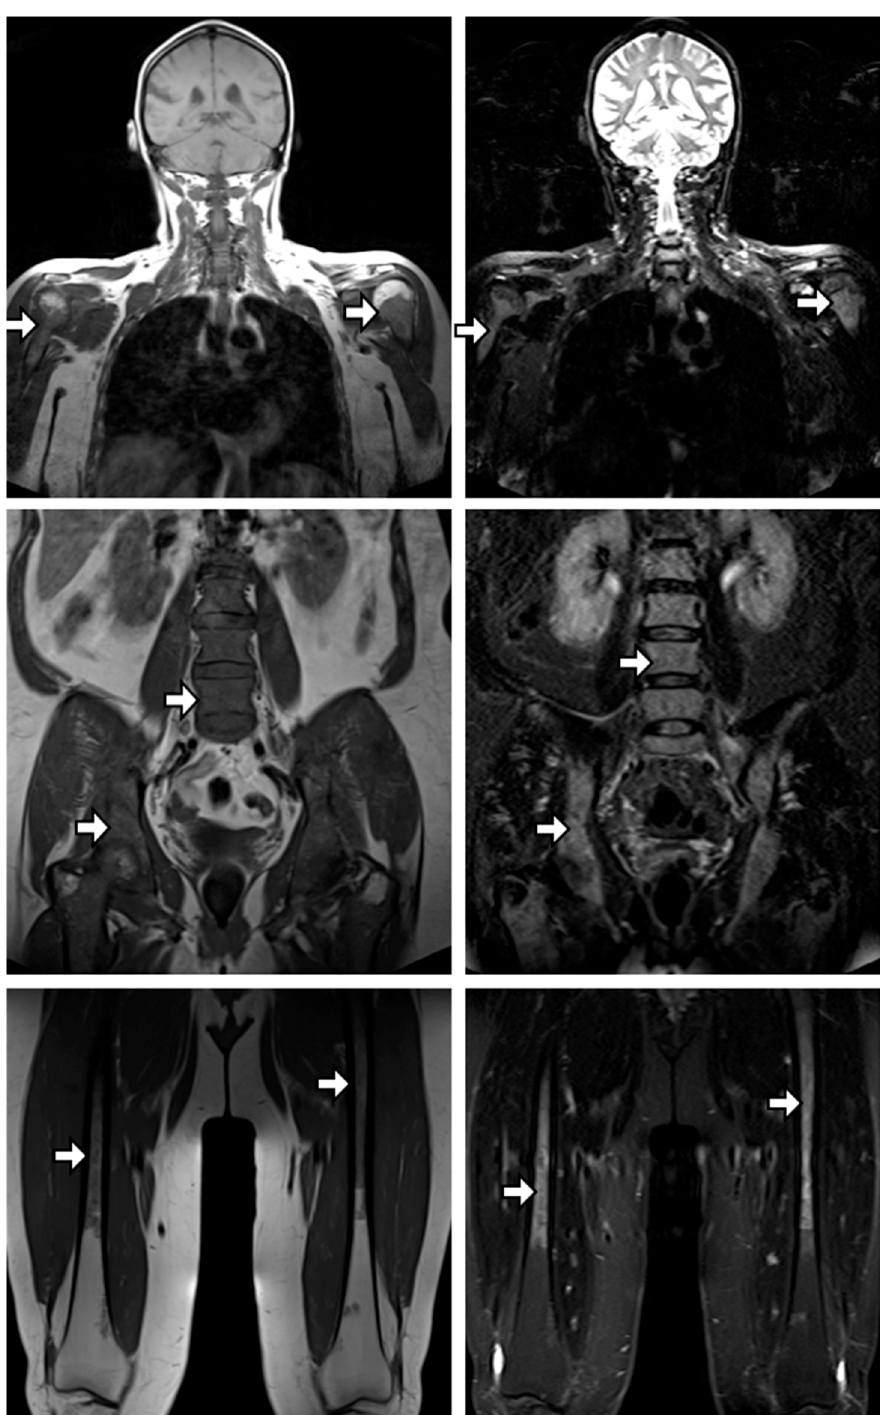
Figure 3. Ubiquitous severe diffuse infiltration. Coronal T1 tse and T2w stir images from a 57-year-old female patient at date of progression due to anemia (hemoglobin = 9.3 g/dL) are displayed. Over the course of the smoldering multiple myeloma (SMM) stage, this patient developed increasing diffuse infiltration, at progression showing severe infiltration in all parts of the skeleton including humeri (upper), spine and pelvis (middle), and femora (lower), with approximately muscle-/disc-isointense bone marrow intensities in T1w tse and marked hyperintense signal in T2w stir images, resulting in the maximal diffuse infiltration score of 24.